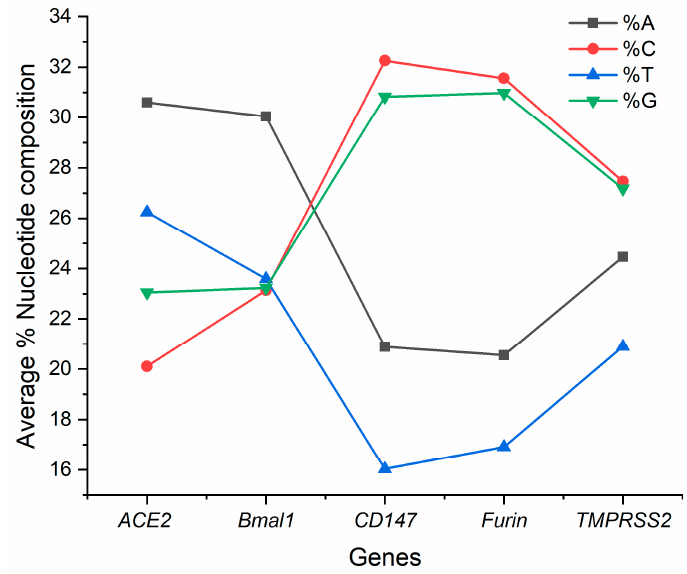
Figure 1. Average per cent composition of the genes.